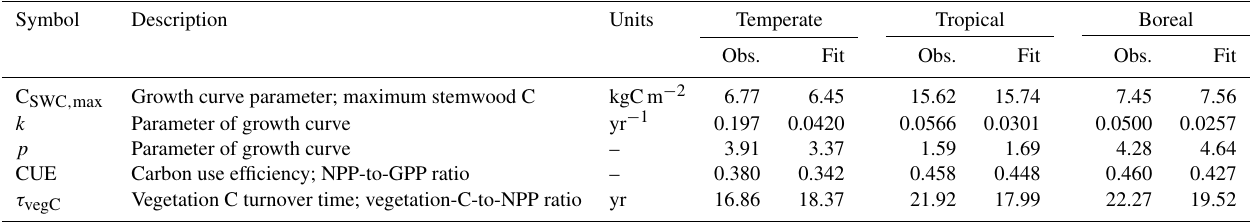
Table 2. Observations and corresponding fits for the 100 included grid cells included in the calibration. Observed values correspond to the mode of the likelihood